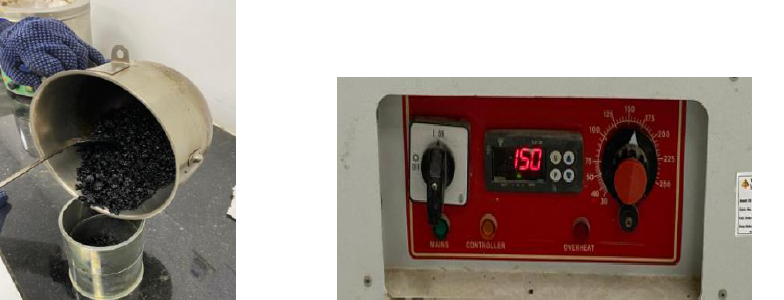
Figure 16. Preparation of Batch-1 Sample